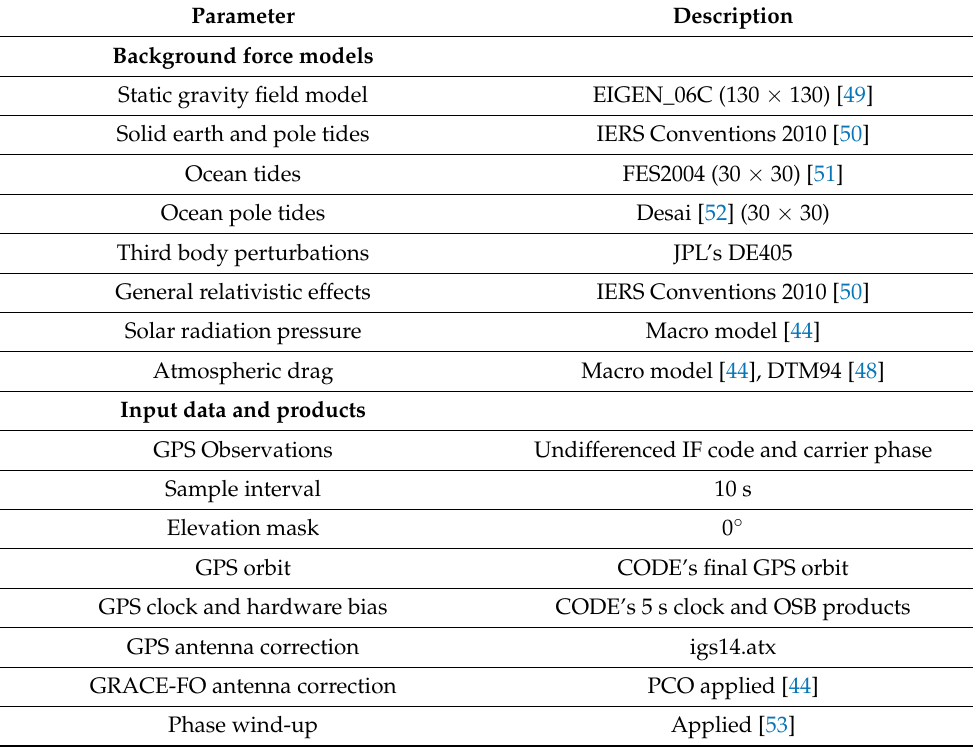
Table 1. POD strategy of GRACE-FO